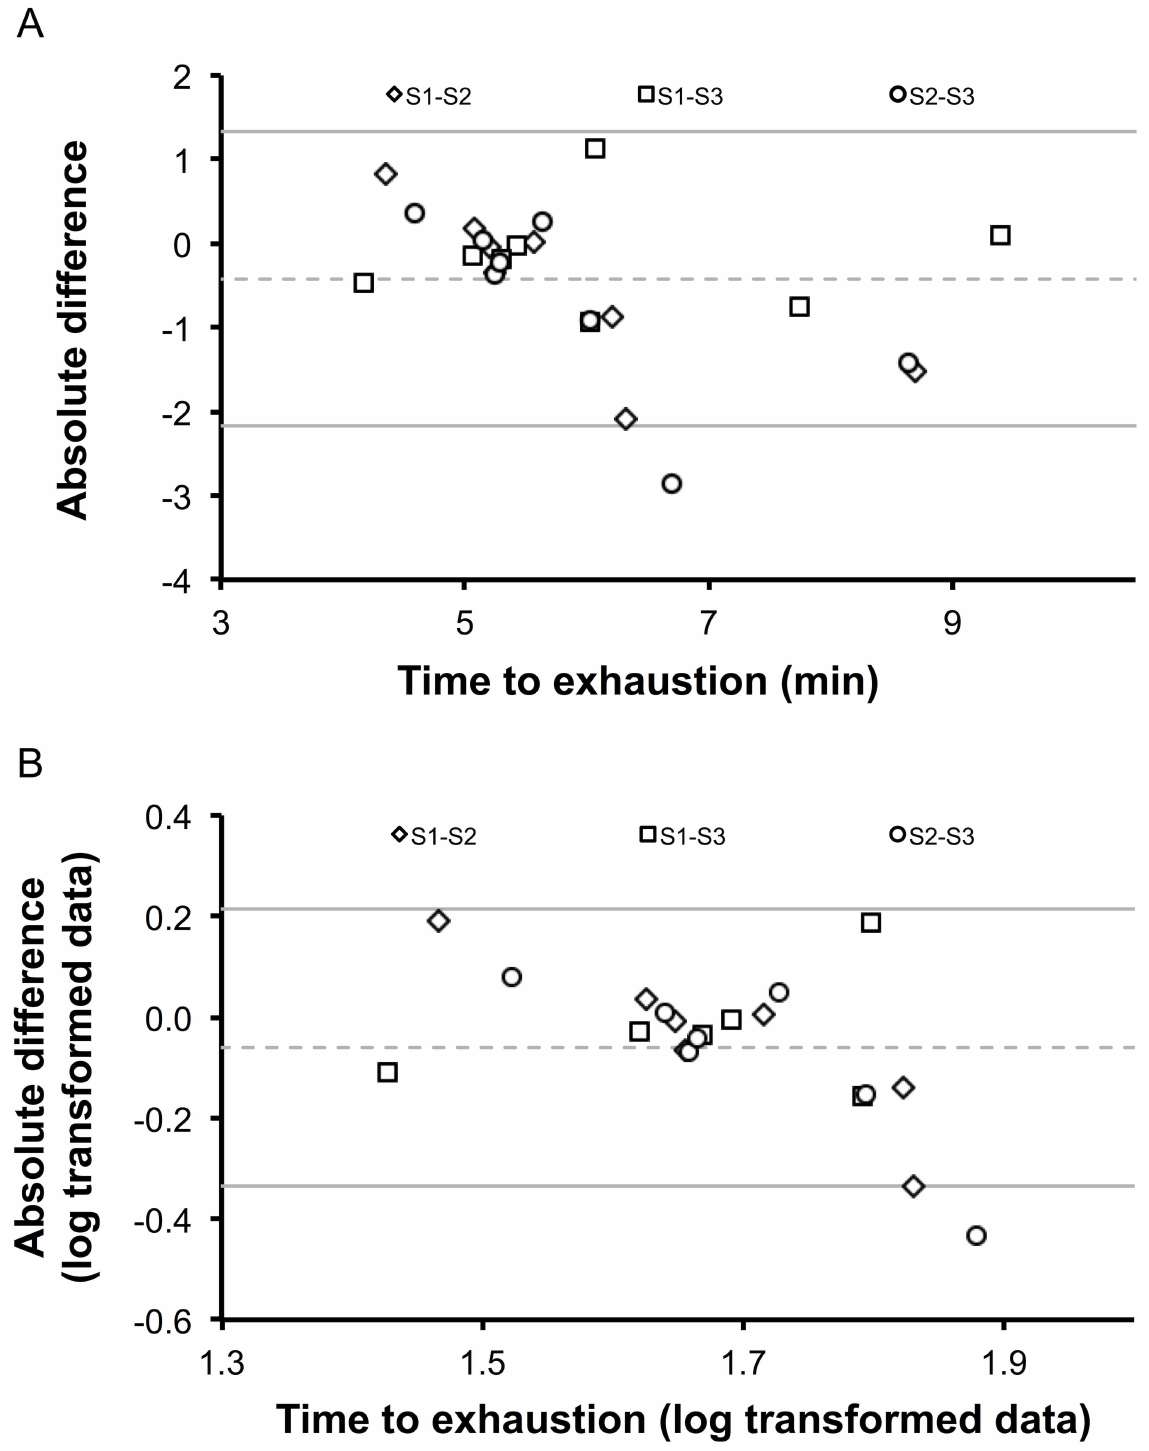
Fig 3. Bland Altman plots (raw data, panel A; log transformed data, panel B) for the time to exhaustion tests. The differences between sessions (S; S1-S2, S1-S3, S2-S3) are plotted against each individual’s mean of the respective two tests. As data were heteroscedastic, limits of agreements ratio (LOA) was also calculatedfrom the log transformed data (LOA = 15.59).